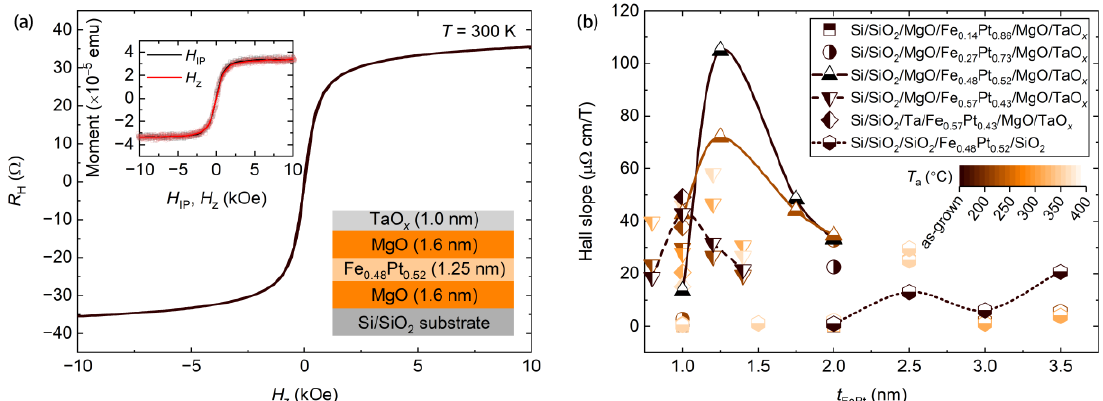
Figure 2. ( a ) Hall resistance R H vs. perpendicular magnetic field H z for a multilayer stack of MgO(1.6)/Fe 0.48 Pt 0.52 (1.25)/MgO(1.6)/TaO x (1.0). The result was measured at room temperature. The right insert shows the schematic of the multilayer structure. The left insert shows magnetization curves as a function of the in-plane magnetic field H IP (black) and the perpendicular magnetic field H z (red). ( b ) Hall slopes at zero magnetic field for different multilayers, obtained from Hall curves. Different symbols represent results for different multilayers and different colors represent results for samples that were annealed at different temperatures. Lines are used to guide eyes.